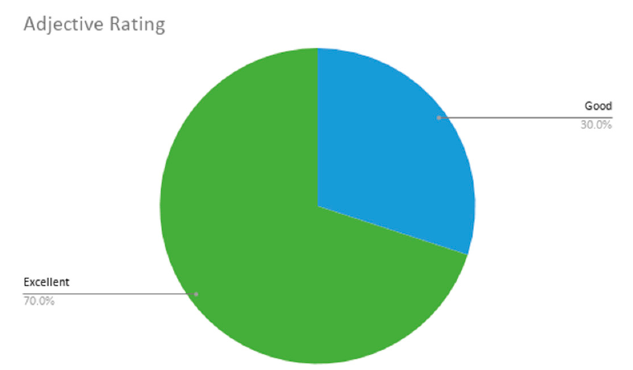
Figure 19. Adjective rating results. The pie chart with adjective ratings (possible options in improving value order: Worst Imaginable, Awful, Poor, OK, Good, Excellent, Best Imaginable); from the possible options, only Good and Excellent were used.